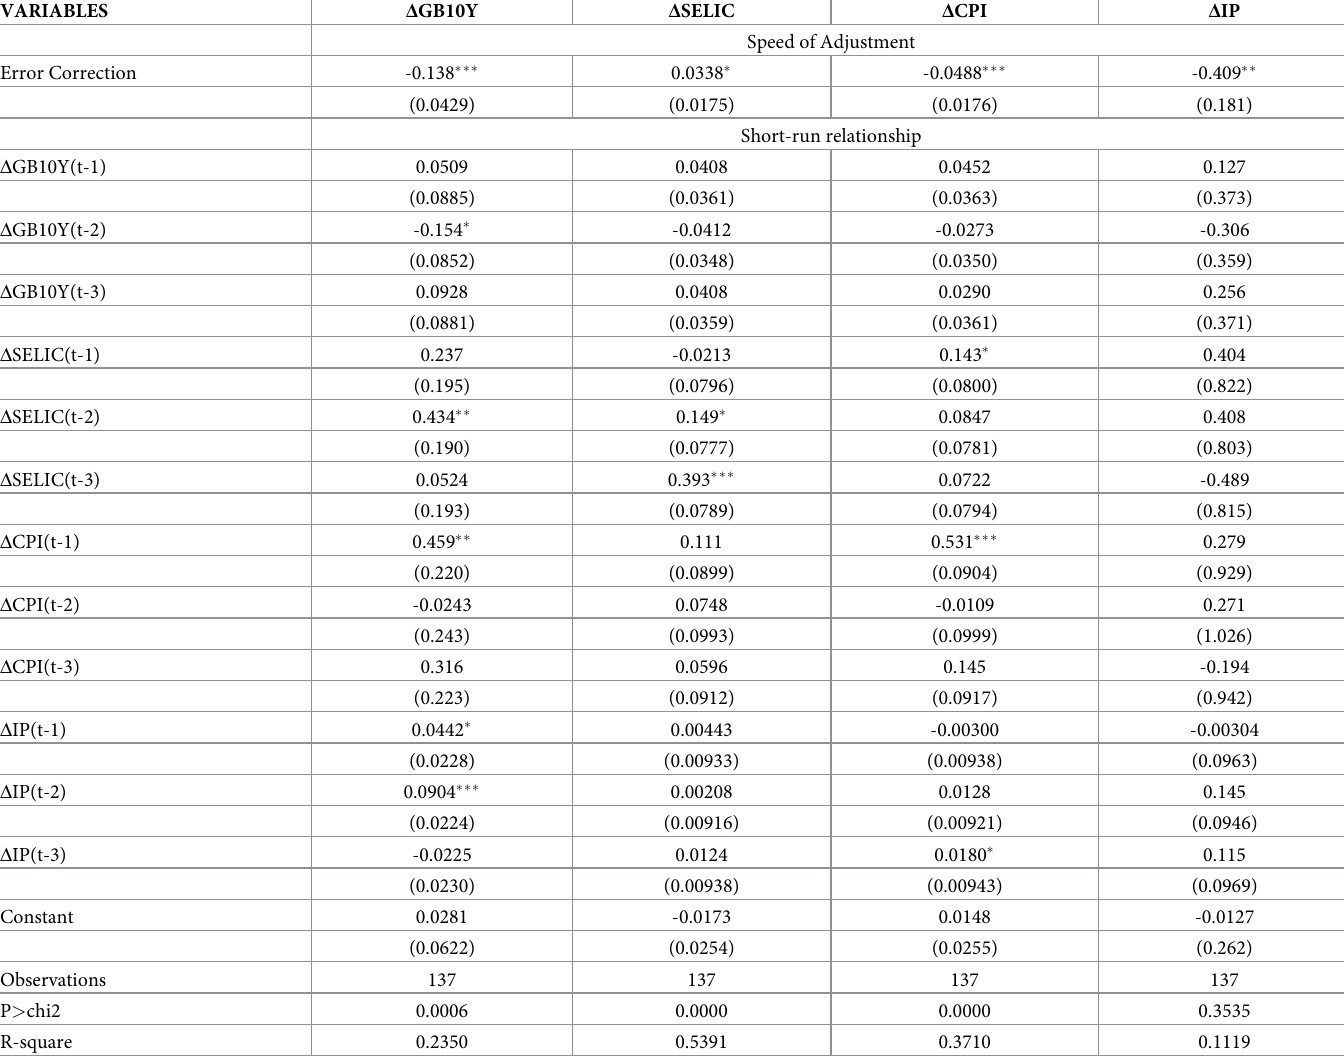
Table 8. Speed of adjustment and short-run relationship from VECM for Eq 7.